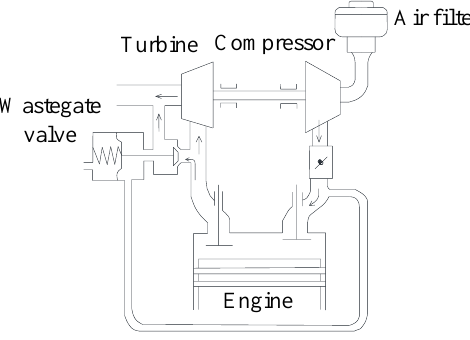
Figure 1. Principle of turbocharged engine.